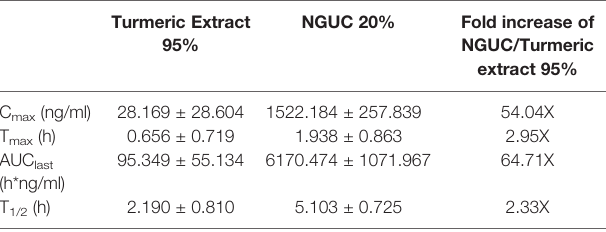
TABLE 1 | Pharmacokinetic parameters after oral administration of NGUC and 95% turmeric extract as an aqueous suspension (dose 200 mg/kg body weight of total curcuminoids).